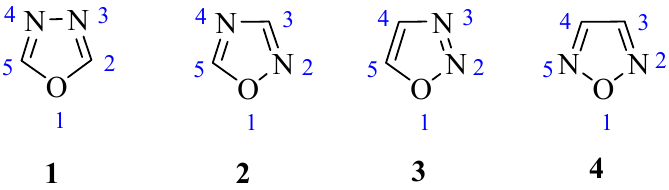
Figure 1. Isomers of oxadiazole.